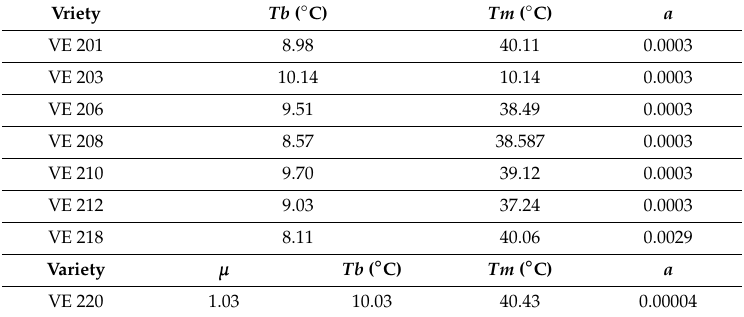
Table 1. Estimated parameters of Briere—1 and Briere—2 models for eight maize varieties (Tonnang et al.